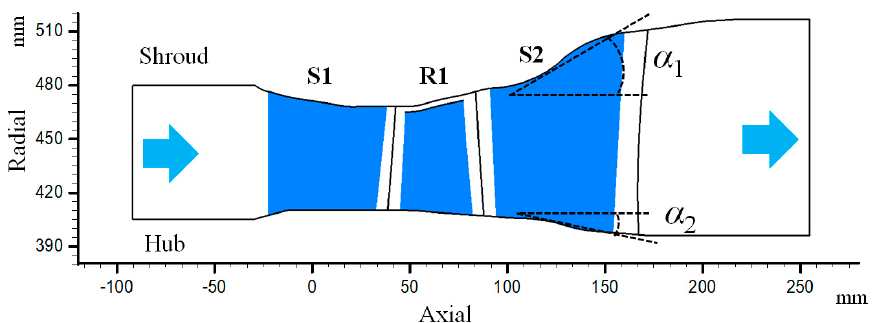
Figure 1. Meridional passage of the 1.5-stage turbine.